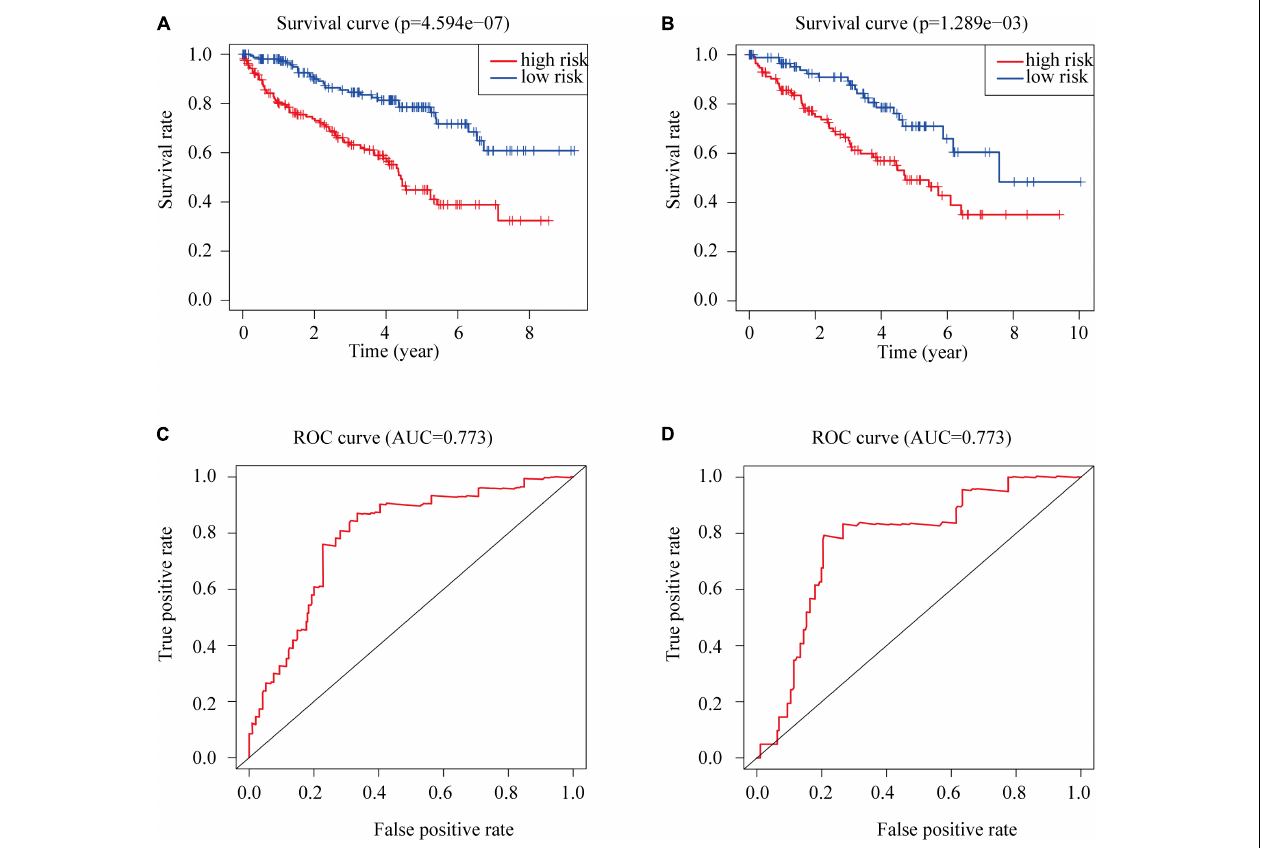
FIGURE 3 | Kaplan-Meier plots of overall survival according to risk scores for (A) the training group and (B) the test group. (C) ROC for overall survival in the training group. (D) ROC for overall survival in the test group.